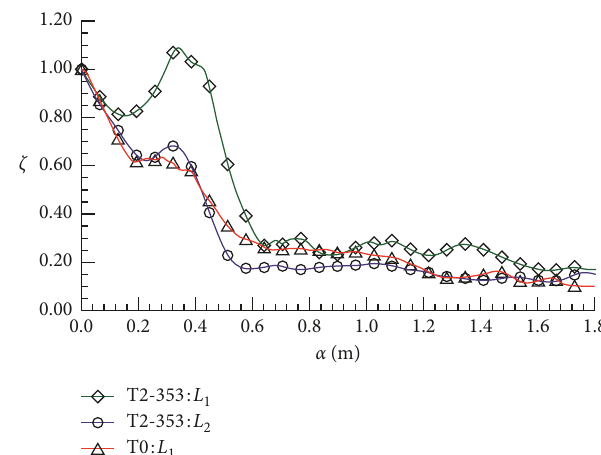
Figure 14: Variation of the dissipation rate on L pile test.